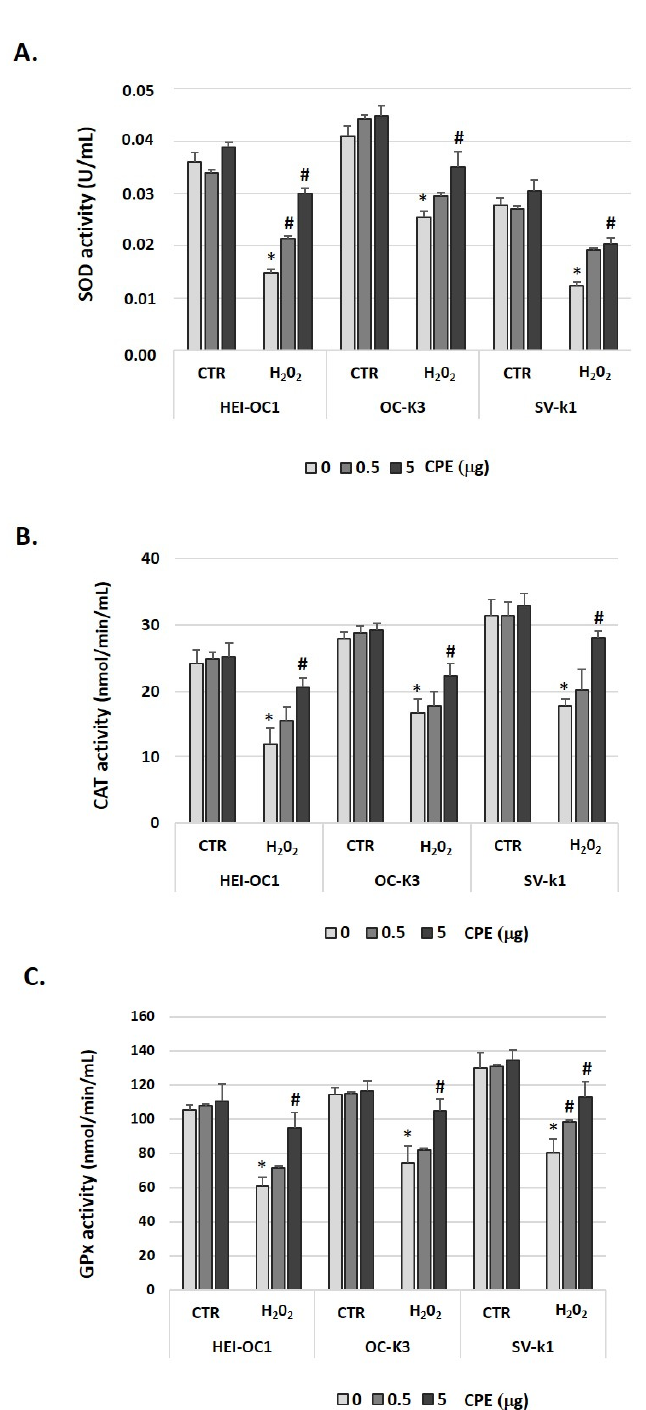
Figure 6. Cocoa treatment modulated antioxidant enzymes in senescence auditory cells. ( A ) SOD, ( B ) CAT, and ( C ) GPx activities were measured by a colorimetric assay in cell lysates of HEI-OC1, OC-k3, and SV-k1 cells post-treatments. Experimental groups: CTR group (0, 0.5 and 5 µ g/mL of CPE for 20 h) and H 2 O 2 group (induced cellular senescence with 100 µ M for 1 h in all groups: 0, 0.5 and 5 µ g/mL of CPE for 20 h). The values represent the mean ± SD of Units/mL (U/mL) ( A ) and (nmol/min/mL) ( B , C ) in triplicate. * p < 0.05 vs. CTR group; # p < 0.05 vs. H 2 O 2 group ( n =